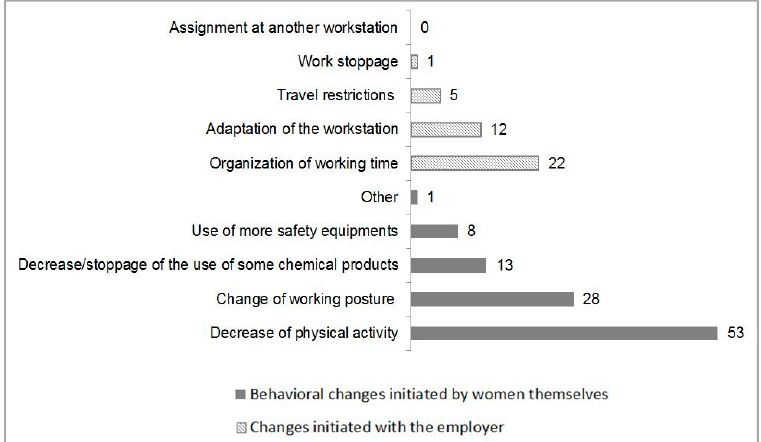
Figure 2. Behavioral changes initiated by women themselves or by their employers ( n = 90).